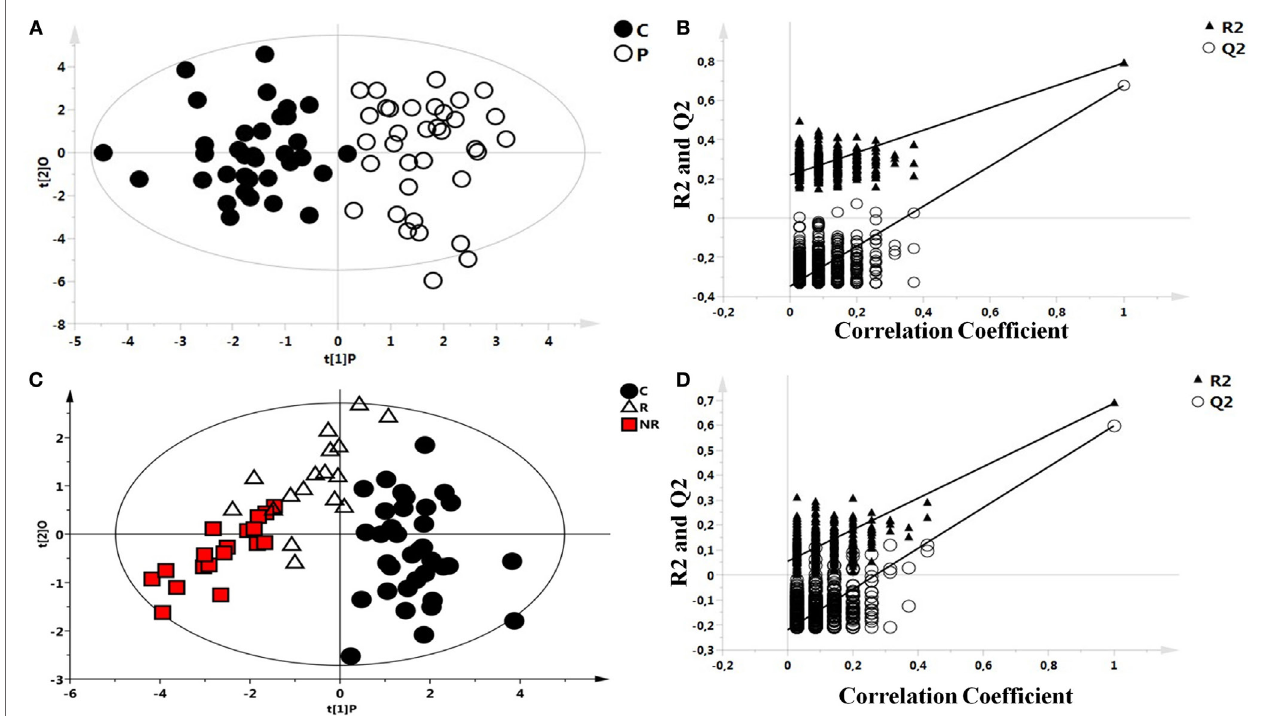
FigUre 1 | Scores plots obtained from nuclear magnetic resonance spectra of serum samples from controls and patients with epilepsy. (a) Scores plot from the multivariate orthogonal partial least square discriminant analysis model between controls (C): C ( ● ) and patients with epilepsy: P (O): each point represents a single serum spectrum, with the position determined by the contribution of the 159 variables. (B) Validation of the corresponding model by permutation test ( n = 500). (c) Scores plot from the multivariate orthogonal partial least square discriminant analysis of a three classes model: healthy subjects ( ● ), responder (R) patients ( Δ ), and non-responder (NR) patients ( ◾ ). (D) Statistical validation of the corresponding model by permutation